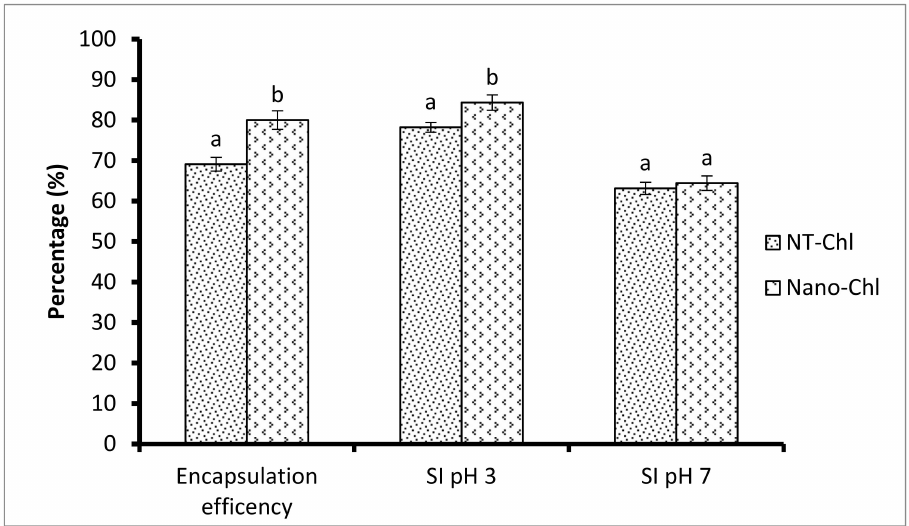
Figure 1. Encapsulation efficiency and swelling index at pH 3 and pH 7 of NT-Chl and Nano-Chl. Bars represent standard deviation (n = 3). Different letters on the bars representing different encapsulation method indicate significant differences ( p <0.05). Key: For caption, see Table